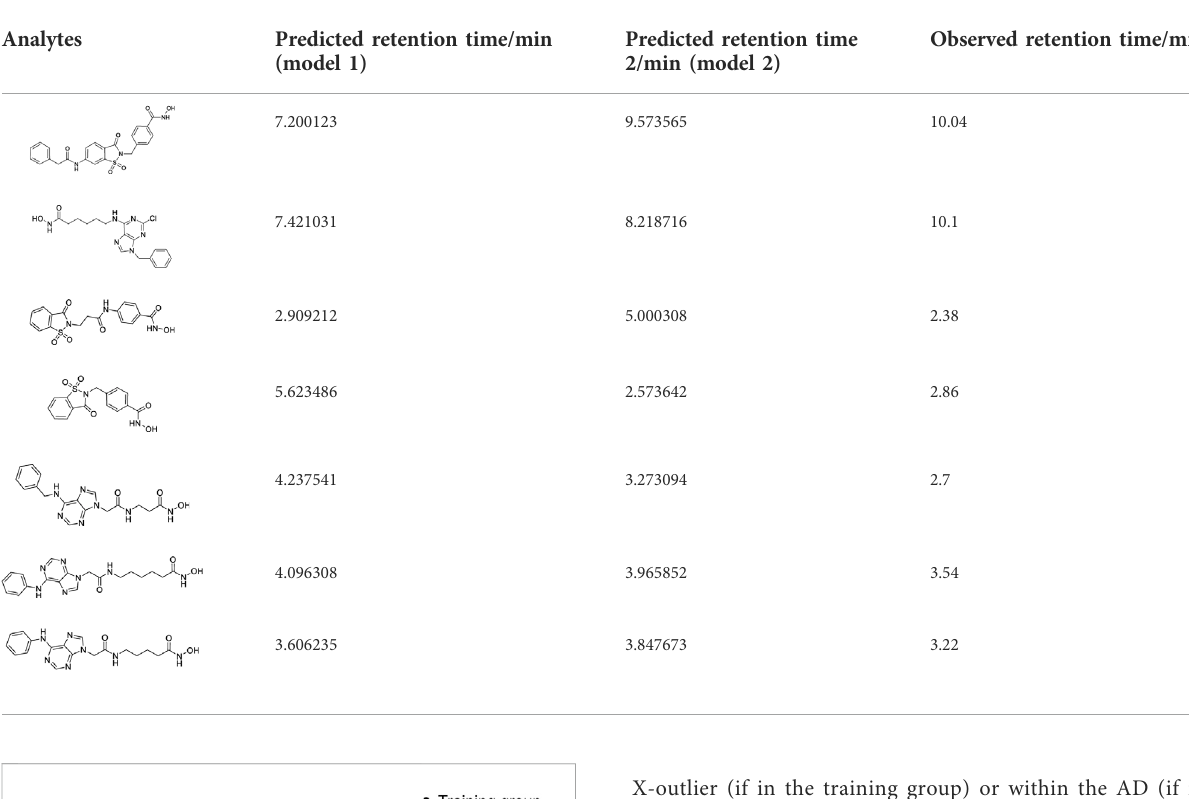
TABLE 6 Prediction of the retention time of compounds in the testing set. Analytes